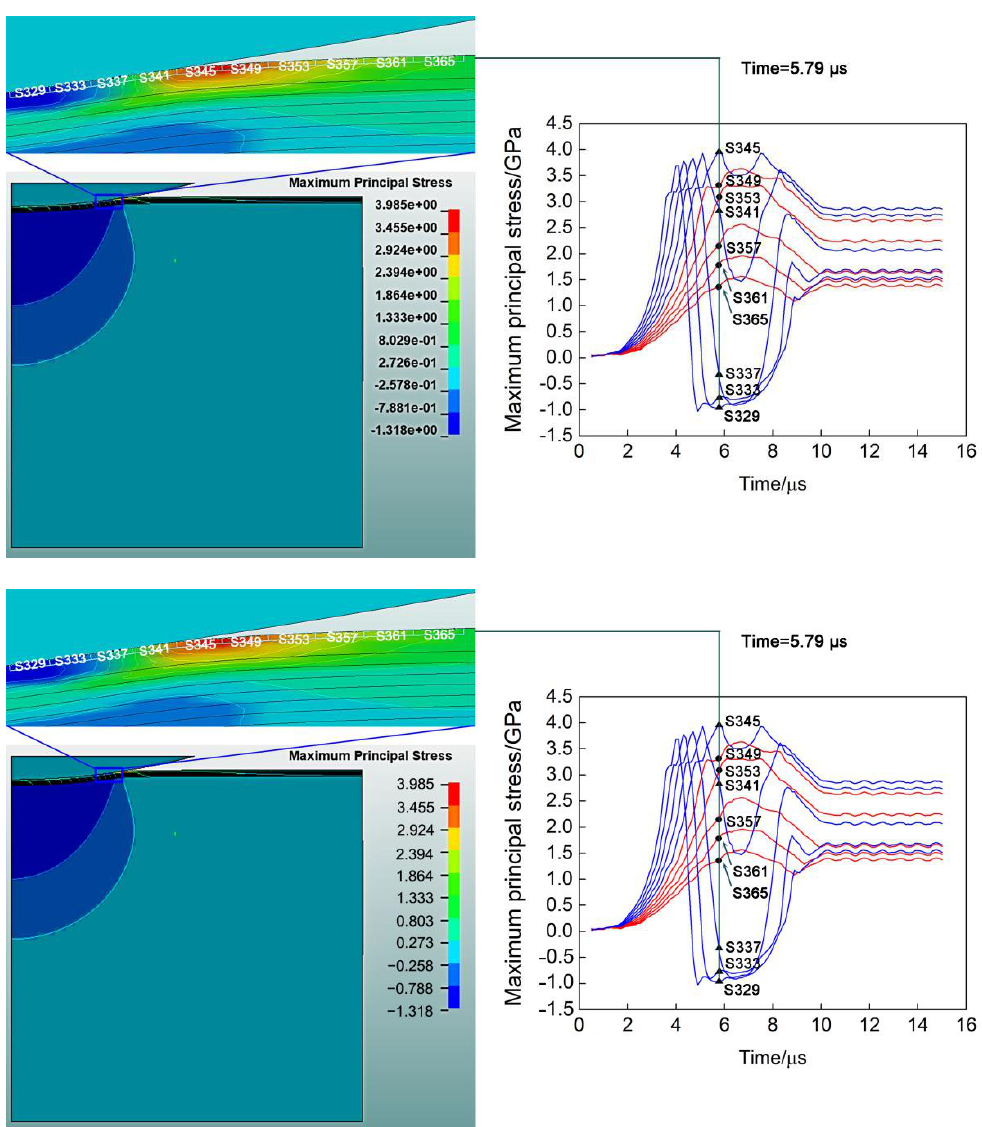
Figure 12. Maximum principal stress distributions in the Mo modified TC4 corresponding to the first 500 N impact.